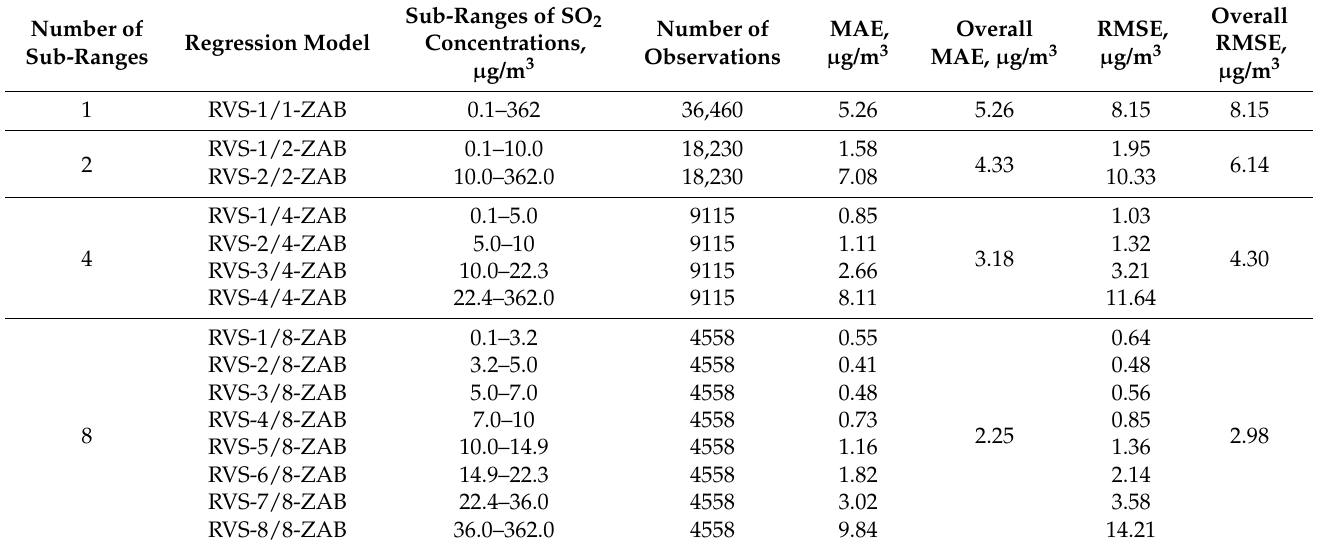
Table 17. Values of approximation errors of SO 2 concentrations in RVS models, Zabrze 2011–2016.